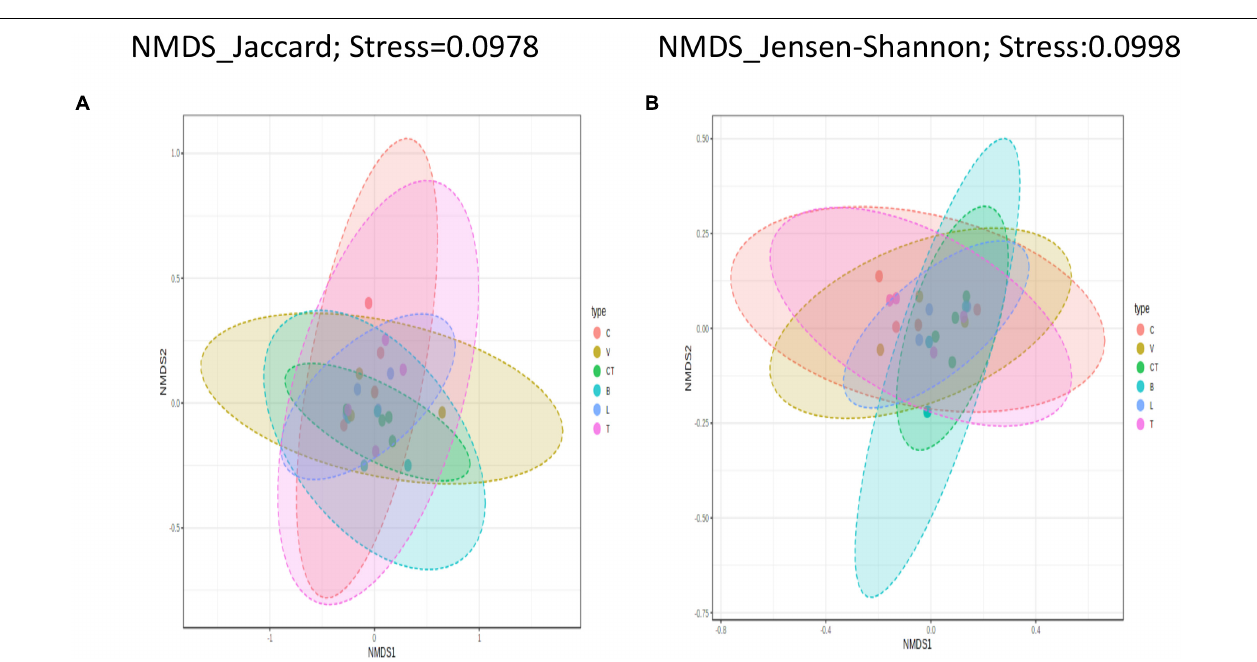
FIGURE 4 | Beta diversity among treatments. Beta diversity plots visualized using Non-metric multidimensional scaling-based ordination at OTU level for different beta diversity metrics (A) Jaccard index, (B) Jensen-Shannon. A stress value of less than 0.1 represents a satisfactory-quality ordination. C, control; V, Virginiamycin; CT, Chlortetracycline; B, Bacitracin Methylene Disalicylate; L, Lincomycin; T, Tylosin.